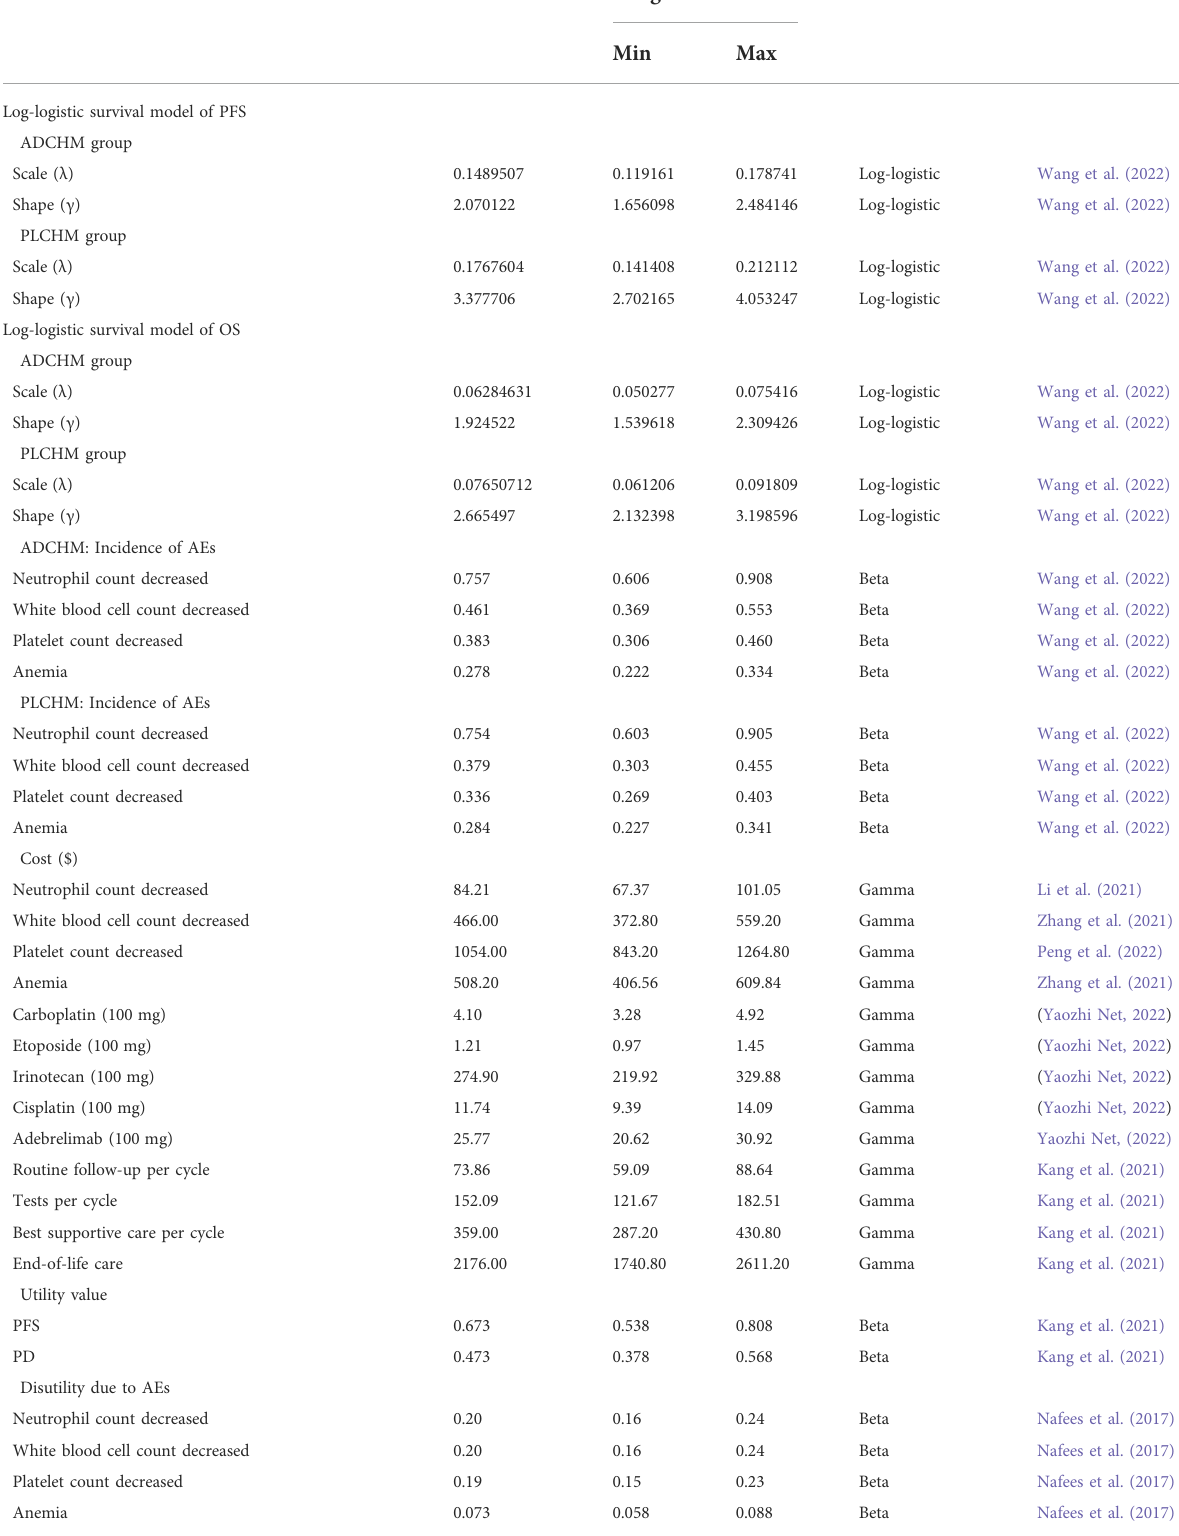
TABLE 1 The basic parameters of the input model and the range of sensitivity